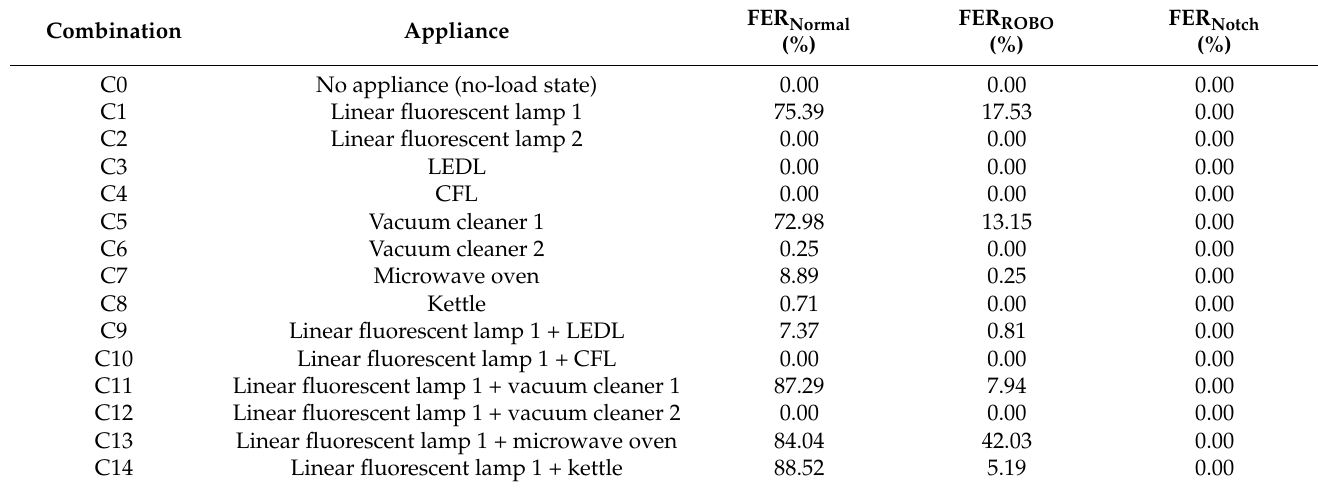
Table 7. Frame error ratio for all three PLC